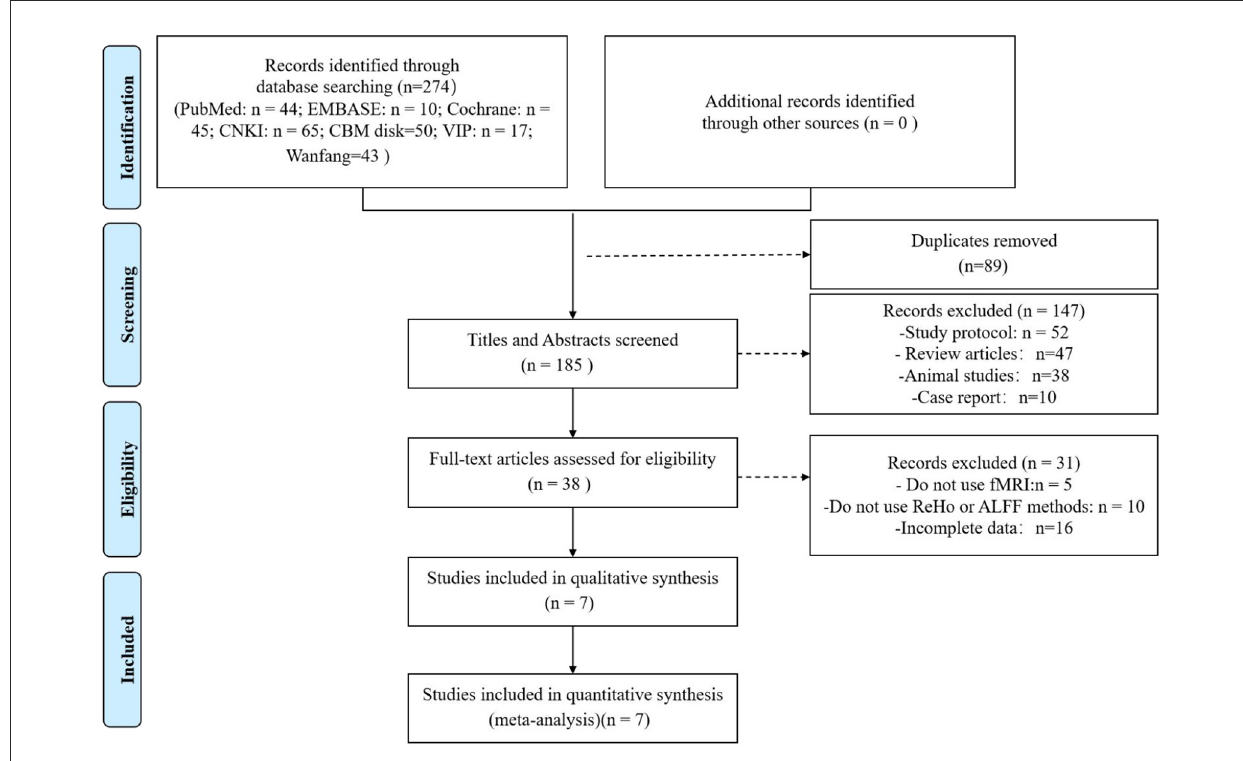
FIGURE1 Flowchart of literature